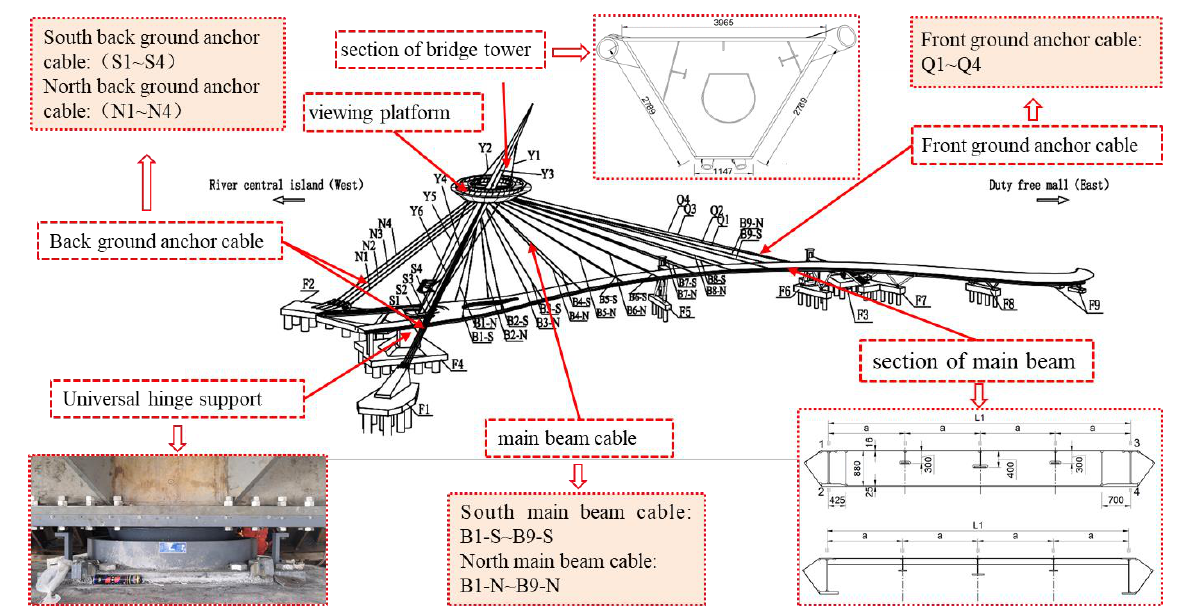
Figure 16. Schematic diagram of the Sanya Landscape Bridge (unit: mm).